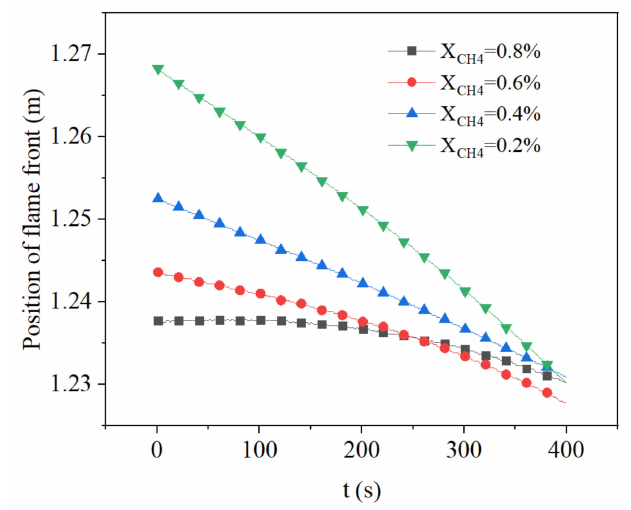
Figure 13. Change of flame front position with time at different concentrations with the inlet flow rate of 700 m 3 /h.